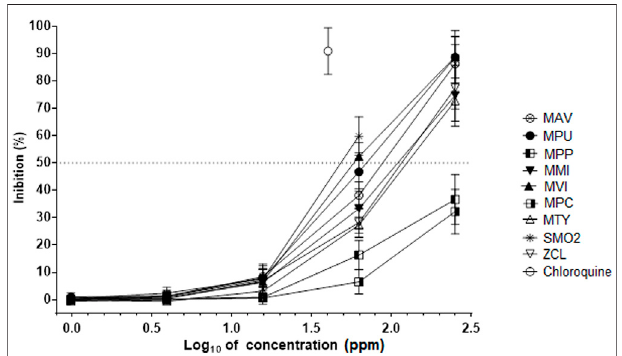
FIGURE 6 | Absence of activity against SARS-CoV-2 in some essential oils. HOF — Hyssopus of fi cinalis ; LAN1 — Lavandula augustifolia 1; LAN2 — Lavandula augustifolia 2; LAN3 — Lavandula augustifolia 3; MPI — Mentha x piperita ; MMB — Mentha x piperita “ Bergamot ” ; SMO1 — Satureja montana ; TVU1 — Thymus vulgaris 1; TVU2 — Thymus vulgaris ; TCI — Thumys x citriodorus . The inhibition rates of SARS-CoV-2